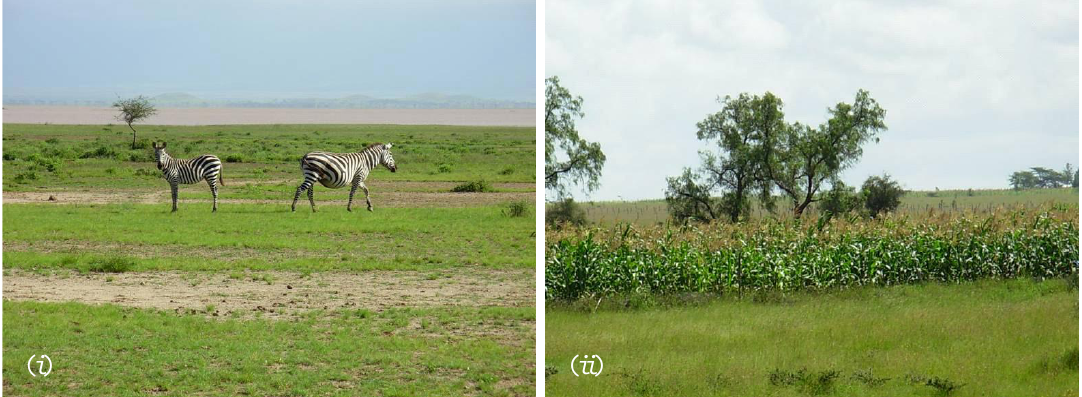
Figure 6. Portraits of land-use change, and loss of Maasai land, in the southern rangelands of Kenya. ( i ) = Zebra in Amboseli National Park (Lake Amboseli is captured in the background), in Loitokitok Division; and ( ii ) = Maize ( Zea mays ) field in Central Division. Photo Credit: Margaret Mwangi.